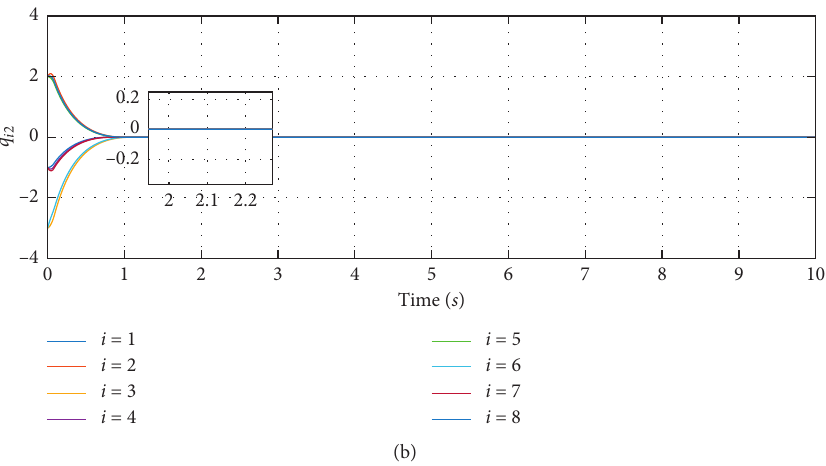
Figure 8: Pictures (a) and (b) reveal the evolution of the errors 􏽥 q